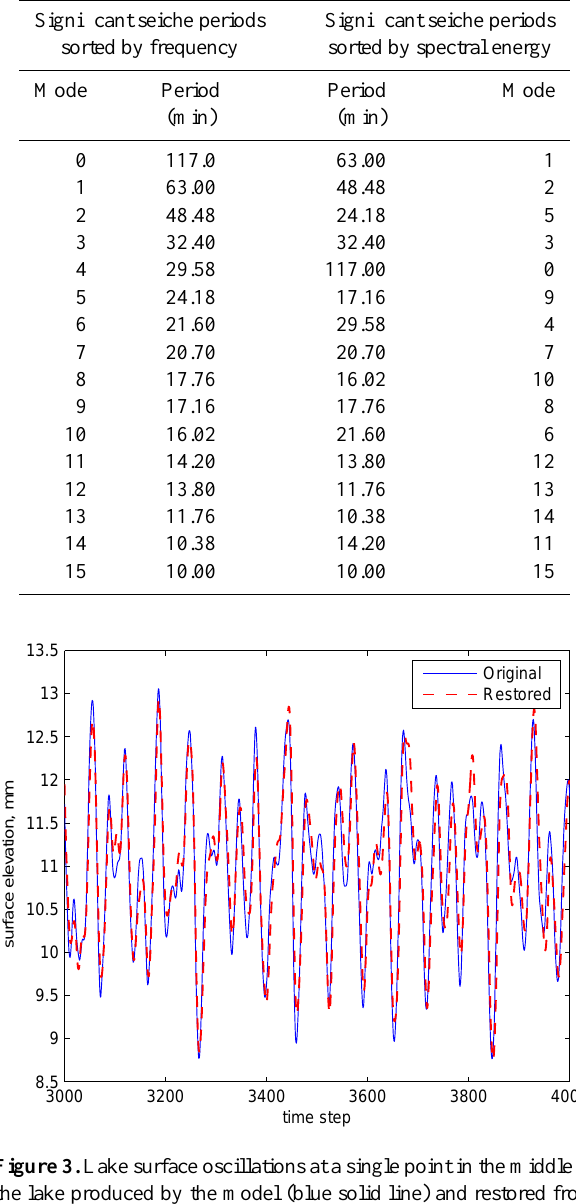
Table 1. Periods of free oscillation modes in Flathead Lake.